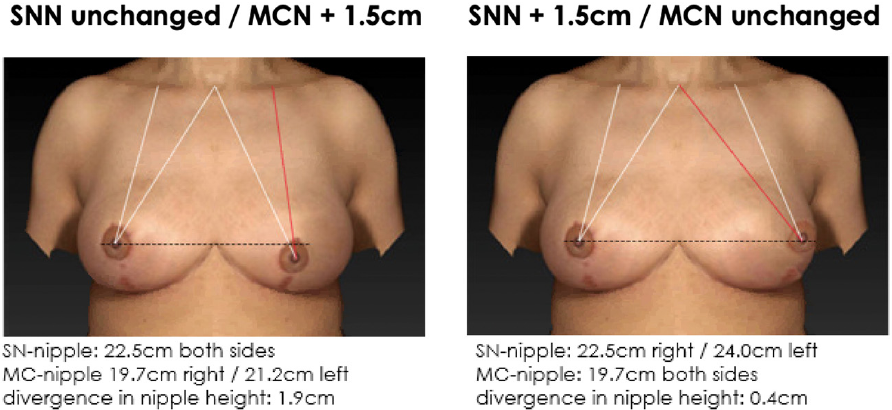
Figure 8. Non-symmetrical mirrored computer-simulated breast models with a modified MC-to- nipple distance and an SSN-to-nipple distance of − 1.0 cm. In total, 98% of the plastic surgeons and 99% of the patients find the image with the unaltered MC-to-nipple distance more attractive than the image with the unaltered SSN-to-nipple distance.